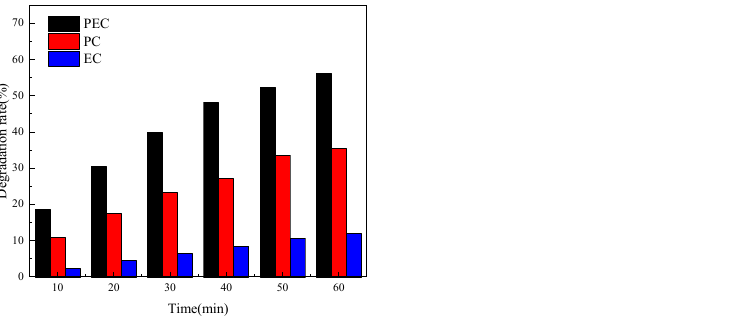
Figure 9. Comparison of the effect of PEC/EC/PC catalytic conditions for the degradation of OTC.